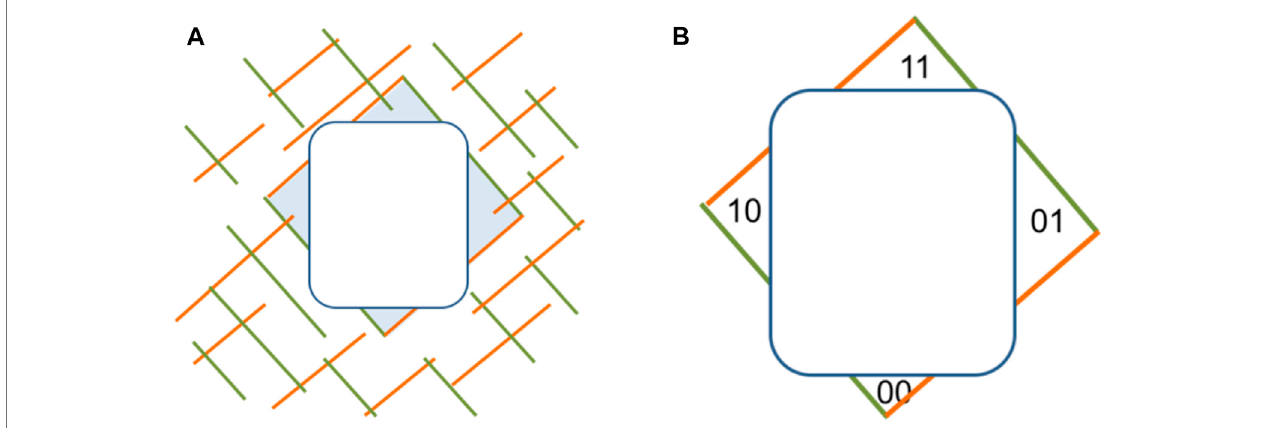
FIGURE 1 | Key blocks on boundary of rectangle-shaped tunnel: (A) four key blocks cut by two joint sets and the tunnel boundary; (B) key blocks labeled by their joint pyramid code.